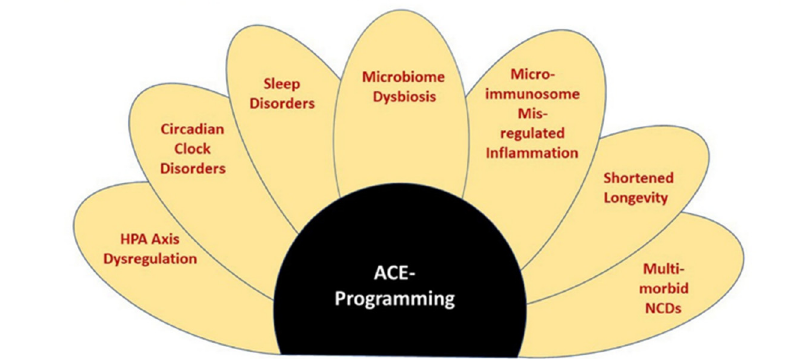
Figure 1. Shows a Venn Diagram in the form of sunflower ray florets connected to Adverse Childhood Experience (ACE)-programming depicted as the central disc floret. The multi-system dysfunctions and dysbioses arising from ACEs are interconnected with each other and greatly affected by the status of the microbiome. For this reason, a lifelong solution to the chronic disorders arising from ACEs requires a holobiont-wide